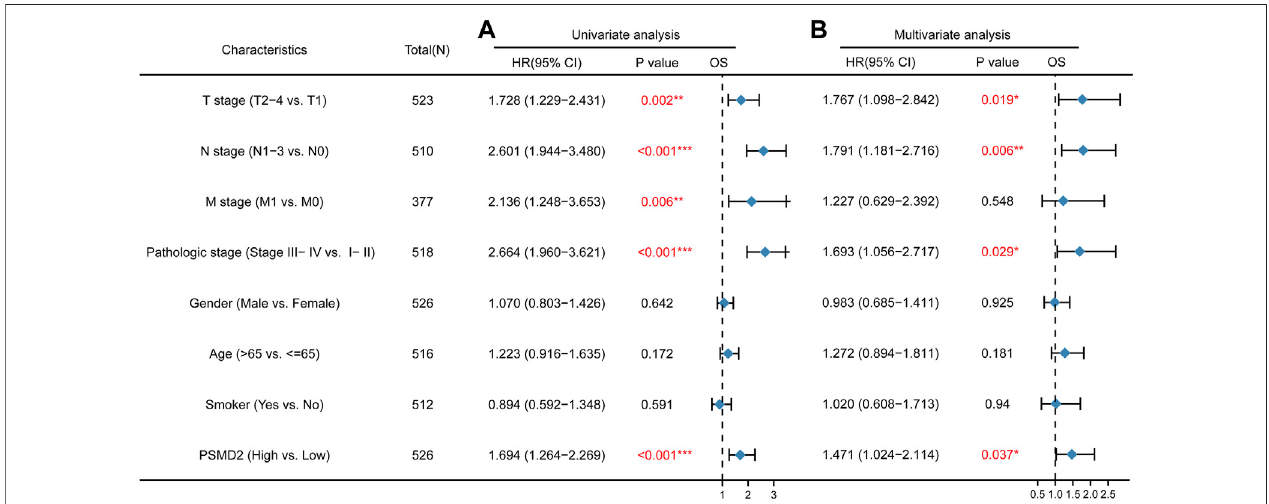
FIGURE 5 | Cox regression analyses and forest plots of prognostic factors for overall survival. (A) Univariate Cox analysis and forest plot results of PSMD2 for OS. (B) Multivariate Cox analysis and forest plot indicated PSMD2 was an independent prognostic biomarker for OS in lung adenocarcinoma. (Red colors mean signi fi cant